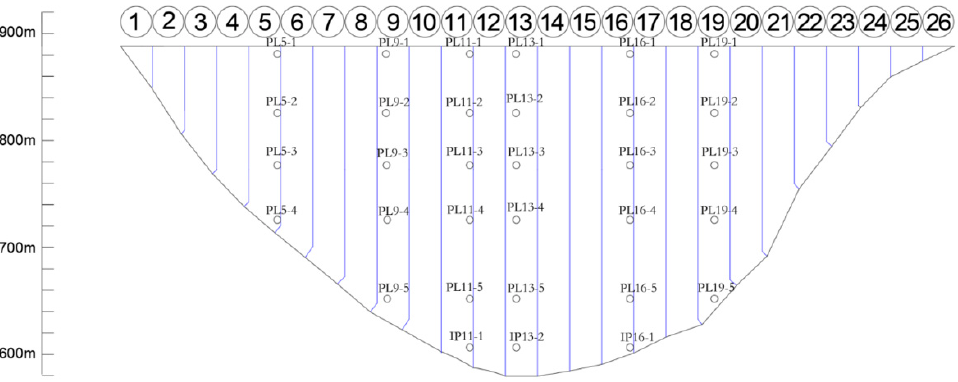
Figure 4. Distribution of deformation measurement points of the arch dam.